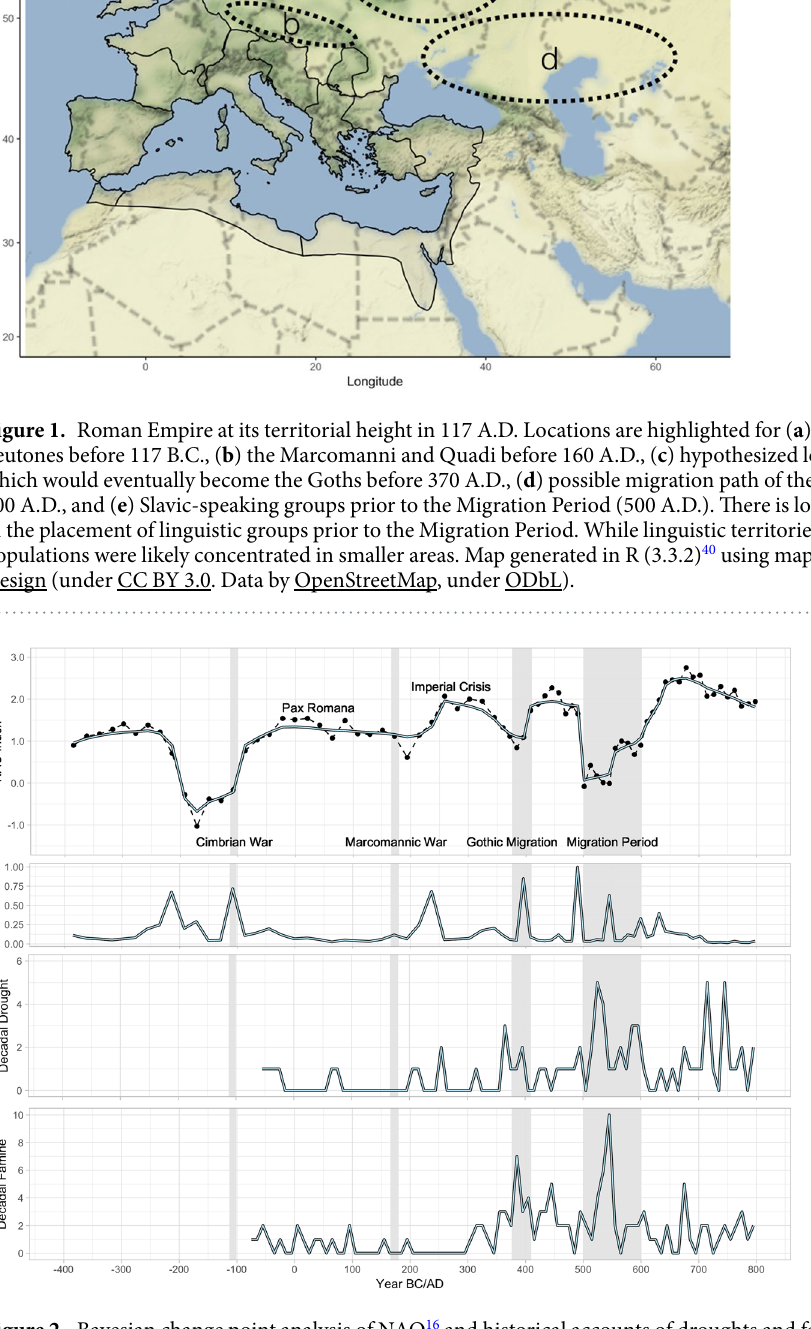
Figure 2. Bayesian change point analysis of NAO 16 and historical accounts of droughts and famine 23 with primary migration events. Figure generated in R (3.3.2) 40